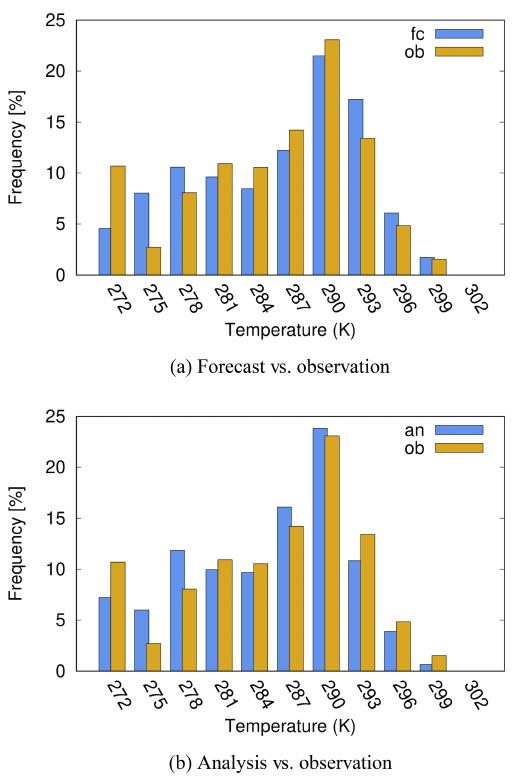
Figure 6. Frequency of observed (yellow) and forecast or analysed (blue) LSWTs over Lake Lappajärvi, 2012–2018, all temperatures included. x axis: LSWT, unit is kelvin; y axis: frequency, unit is